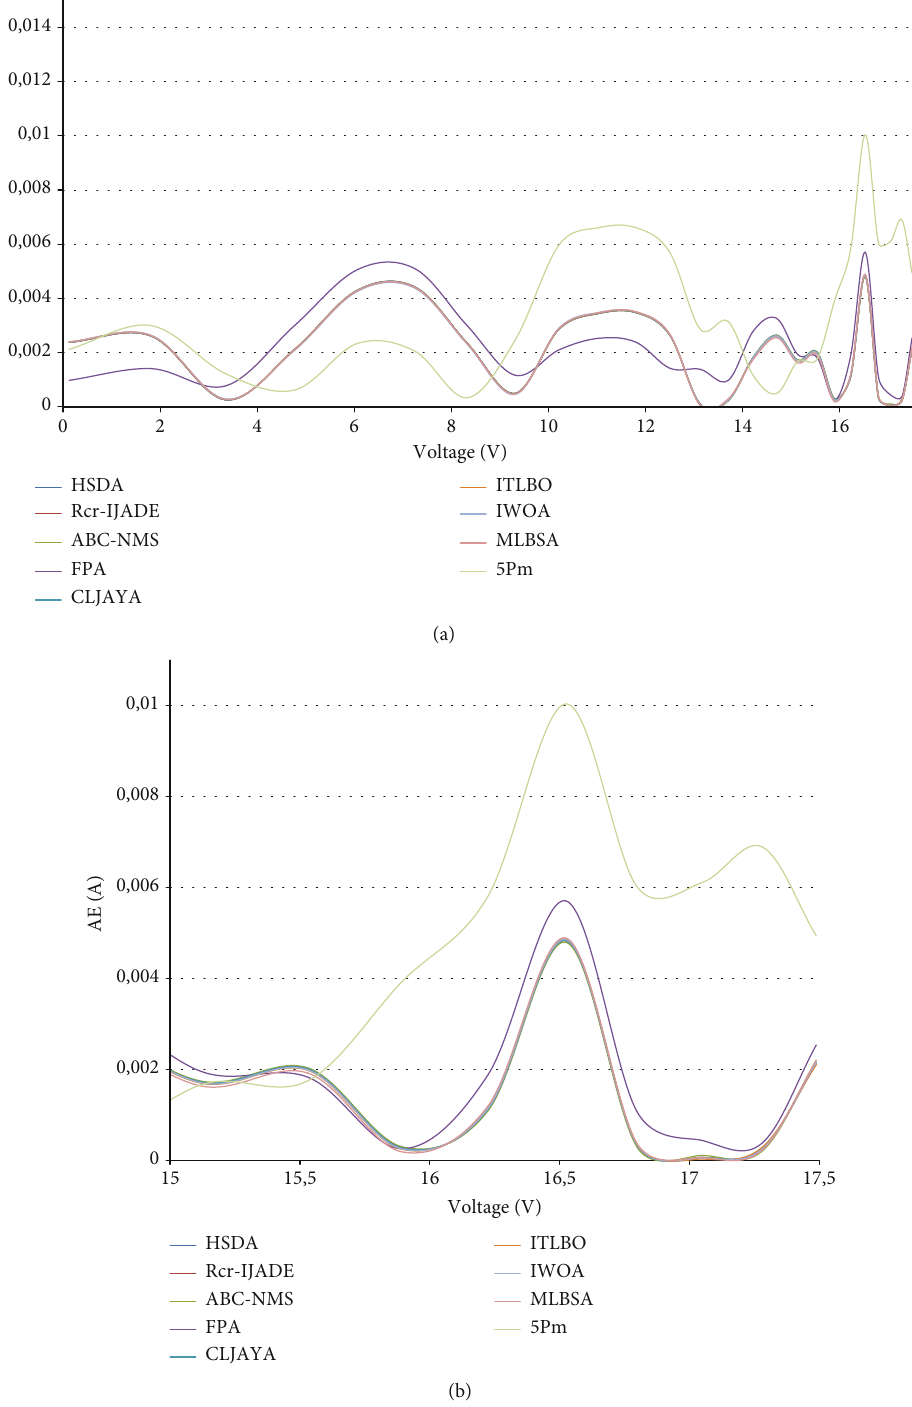
Figure 5: (a) The absolute current error (AE) for PWP201 photovoltaic panel; (b) AE in open-circuit voltage